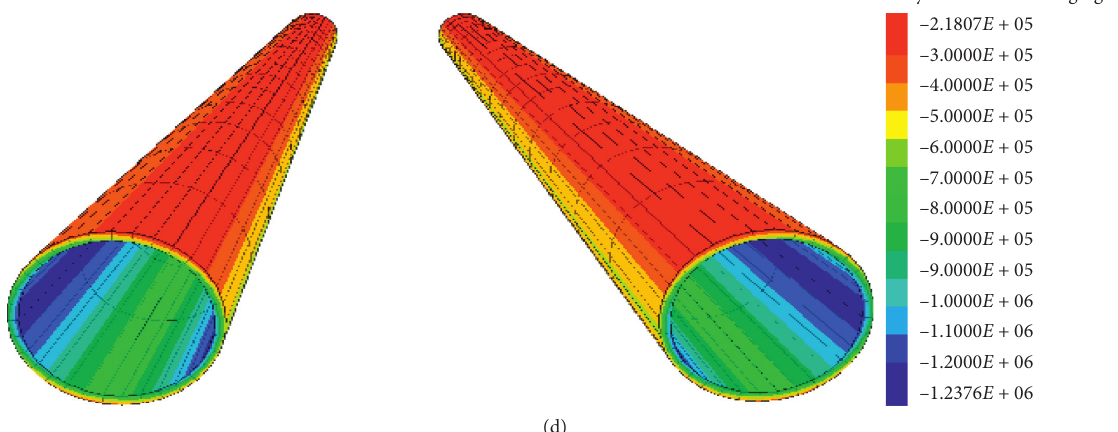
Figures 10: Numerical simulation results after soil layer strength weakening. (a) Surface settlement. (b) Left arch waist settlement of right line of line 1. (c) Right arch waist settlement of right line of line 1. (d) Lining stress of line 1 after the construction of double line of line 5 (unit: